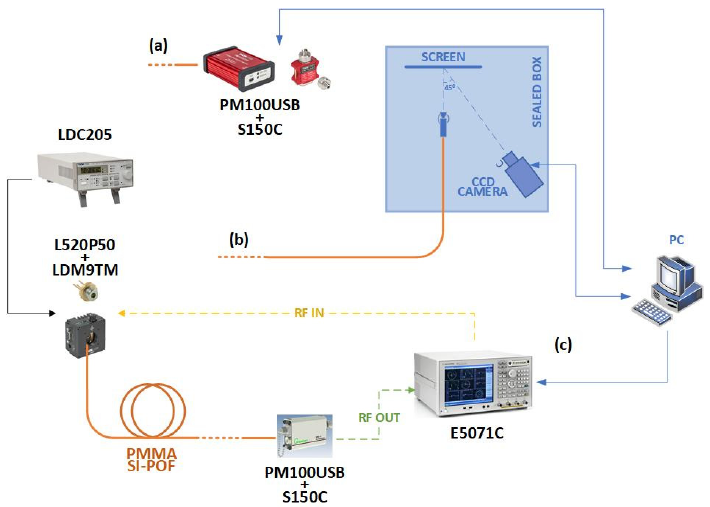
Figure 1. Experimental setup system for measurement acquisition. ( a ) Optical power subsystem; ( b ) far field pattern images subsystem; ( c ) S 21 transmission parameter subsystem. ( b ) far field pattern images subsystem; ( c ) S 21 transmission parameter